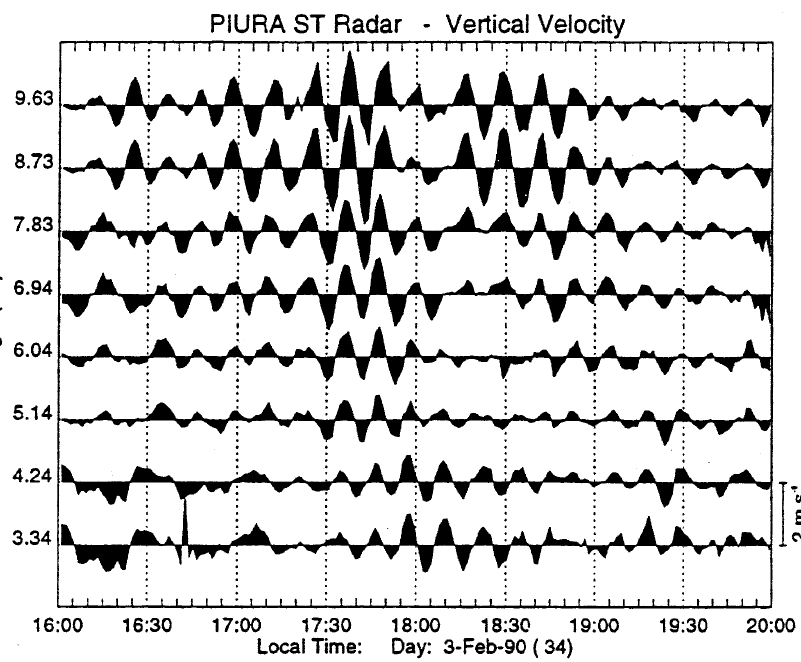
Fig. 5. Wave-like variations of velocity in the vertical antenna mode observed with the Piura ST radar wind profiler (from Liziola and Balsley, 1997, Copyright American